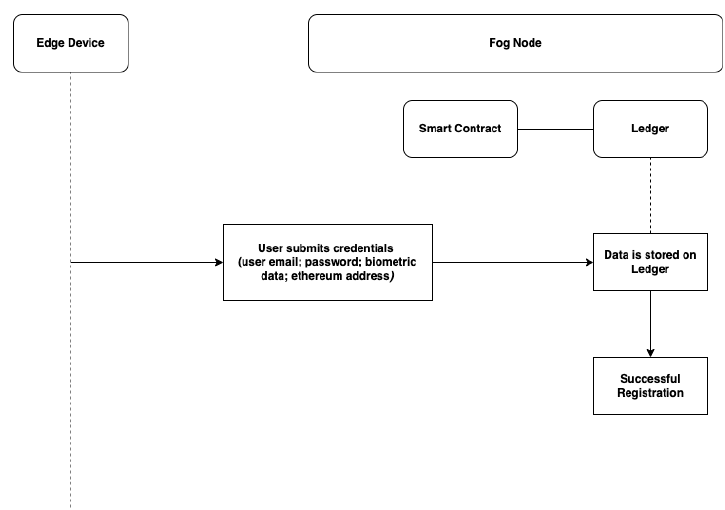
Figure 2. Flow diagram for user